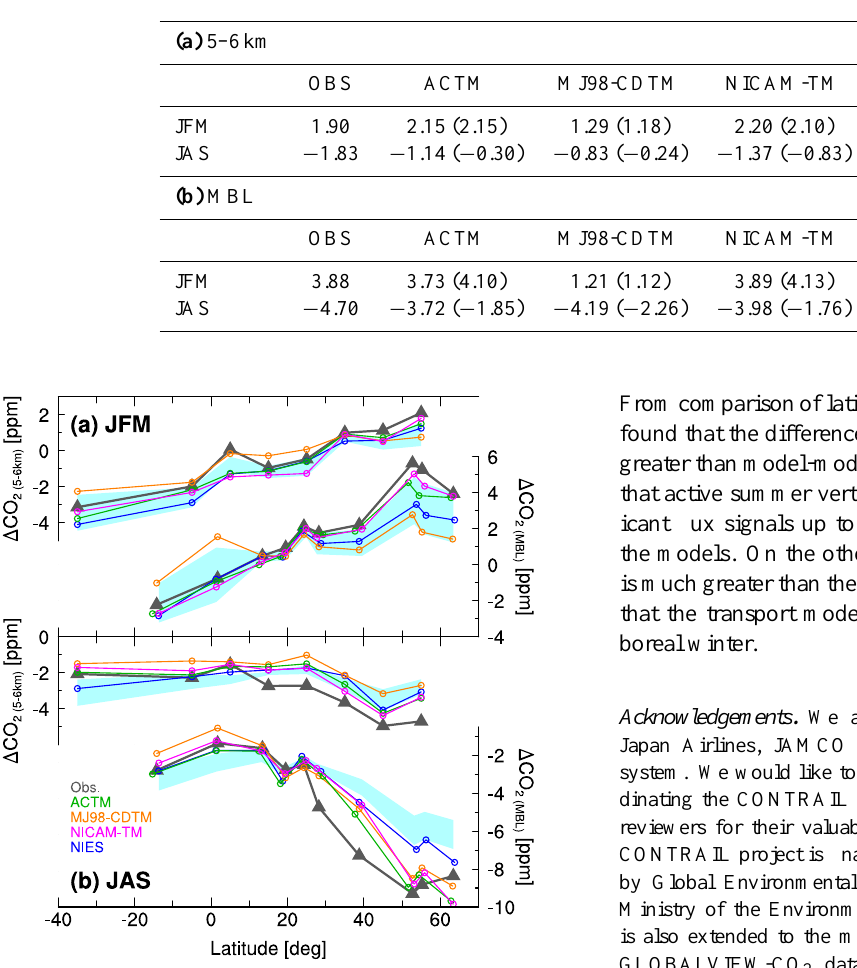
Fig. 9. Latitudinal mean profile of 1 CO 2 at 5–6km in the free- troposphere (upper) and at the marine boundary layer (MBL) sites (lower) for January-February-March (JFM) (a) and July-August- September (JAS) (b) of 2007. Gray triangles with lines show the observed data from CONTRAIL. The symbol/line and shaded area convention are same as Fig.